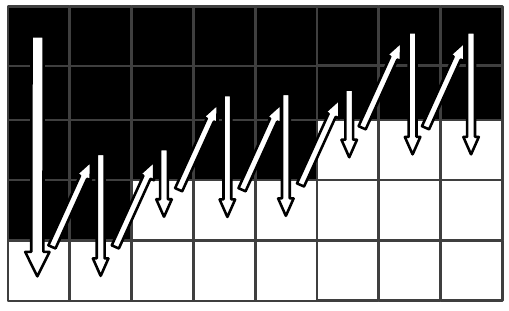
Figure 9. Principle diagram of feature-line fast-scanning algorithm.